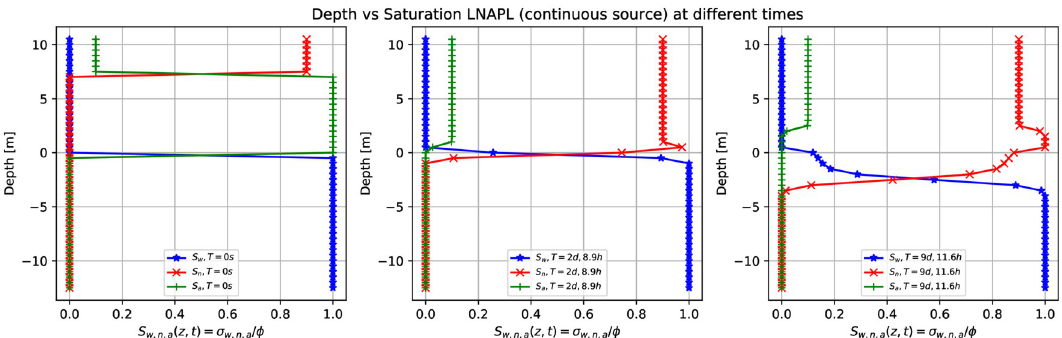
Fig 3. Depth vs. saturation of LNAPL (continuous source) at different times. Three-dimensional numerical simulation results of the depth as a function of the water saturation S w (blue points), LNAPL saturation S n (red points), and air saturation S a (green points) at various times for a continuous leak of LNAPL of Fig 2. Initially, at t = 0 s, there is a sharp front of contaminant saturation situated on top of the grid, rapidly reaching zero when the height decreases. At the same time, it is filled by the air saturation (green point) in the unsaturated zone and water saturation in the saturated zone. Notice that the sum of the three-phase saturations is always one. For later times is being observed how the contaminant (red points) moves toward the saturated zone and remains floating while moving with the direction of the groundwater